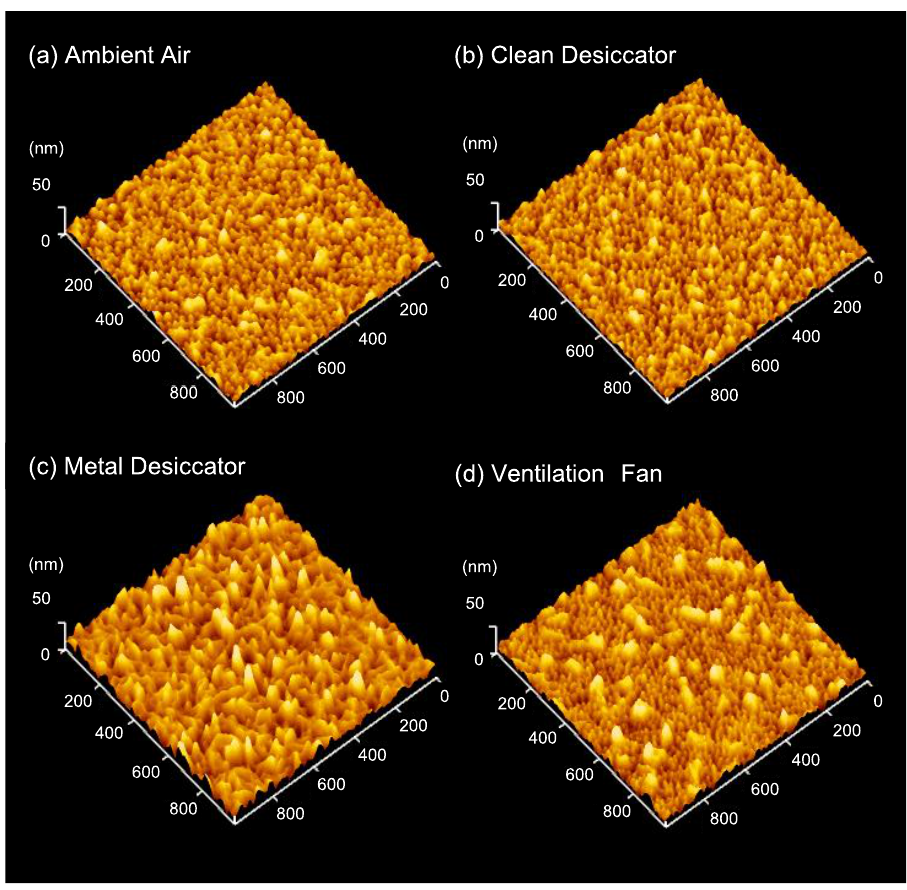
Figure 7. AFM images of Ag/Si stored ( a ) in ambient air, ( b ) inside the clean desiccator, ( c ) inside the metal desiccator and ( d ) near the ventilation fan for 14 days.